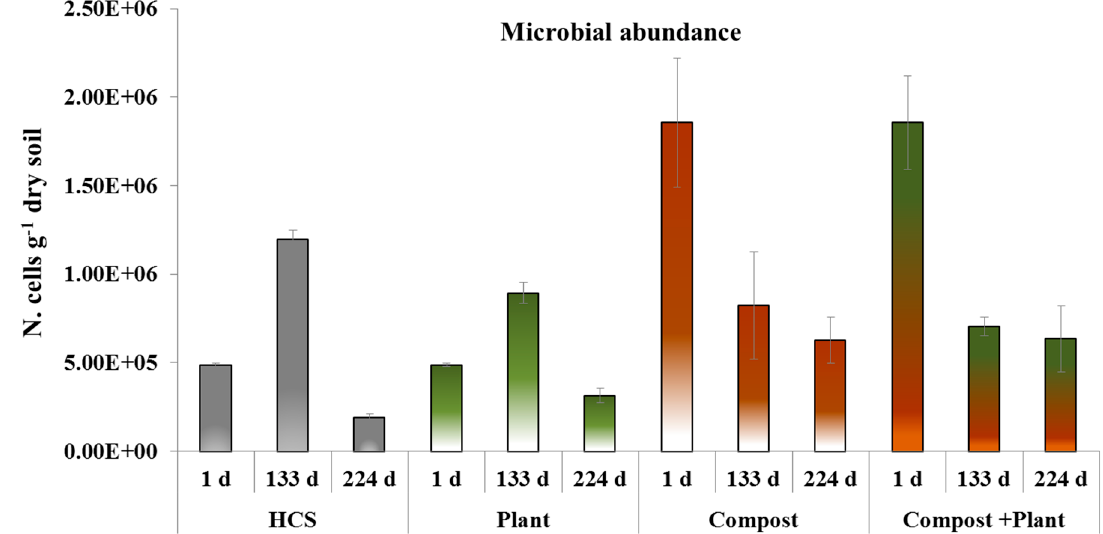
Figure 3. Microbial abundance (No. cells g − 1 dry soil) in the three sampling times (days 1, 133 and 224).